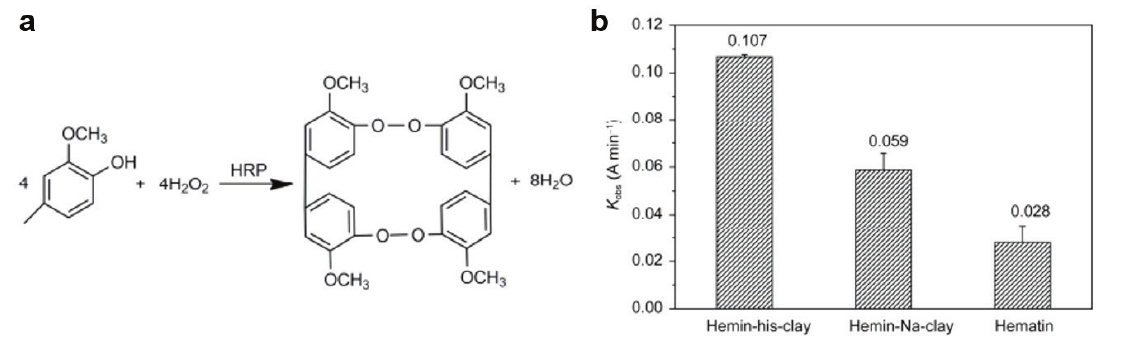
O catalysed by HRP; (b) Observed rate constants of haemin@histidine-clay, haemin@clay and native 2 2